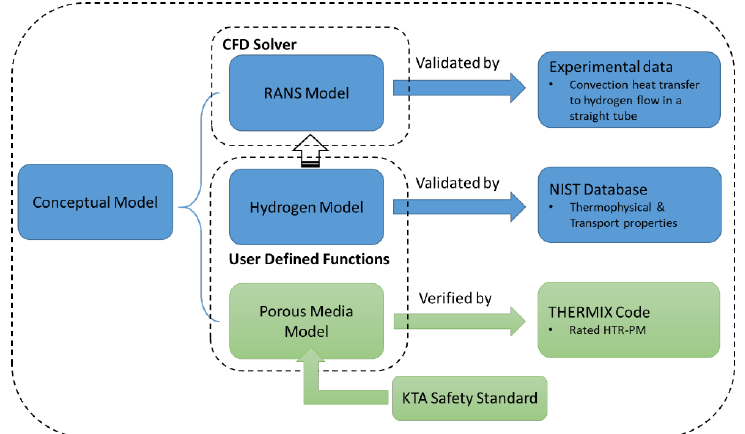
Energies 2019 , 12 , 3590 Figure 7. Partial validation of the numerical approach. Figure 7. Partial validation of the numerical approach.